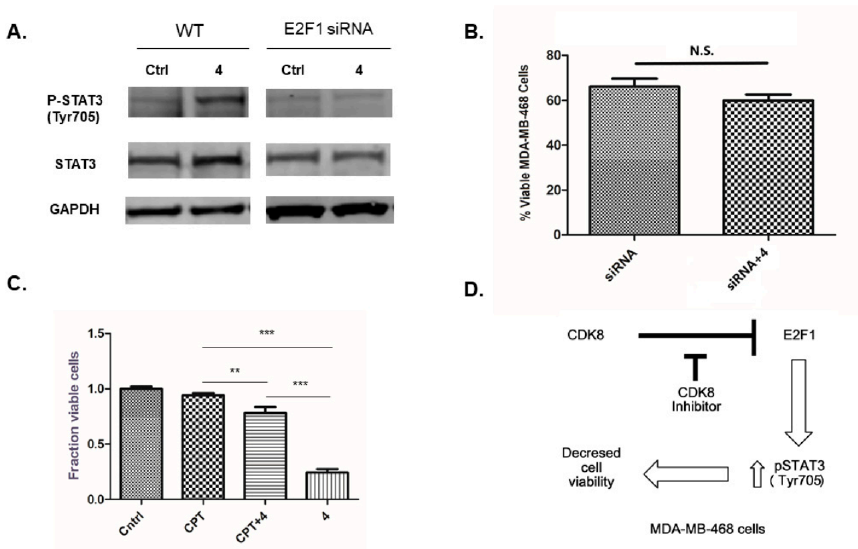
Figure 3. ( A ) Comparison of treatment with 10 µ M inhibitor 4 (24 h) on STAT3 phosphorylation in wild-type (WT) MDA-MB-468 cells and MDA-MB-468 E2F1 knockdown cells (E2F1 siRNA). ( B ) E ff ect on MDA-MB-468 cell viability of E2F1 knockdown alone (siRNA) and with 10 µ M inhibitor 4 (72 h) (siRNA + 4 ). ( C ) E ff ect on MDA-MB-468 cell viability of treatment (10 µ M, 72 h) with STAT3 phosphorylation inhibitor cryptotanshinone (CPT), CPT + inhibitor 4 co-treatment, and treatment with 4 alone compared to vehicle treated control (Cntrl). ( D ) Proposed CDK8 inhibitor mechanism. N.S. p > 0.05 (not significant), ** p < 0.005 (significant), *** p < 0.001 (very